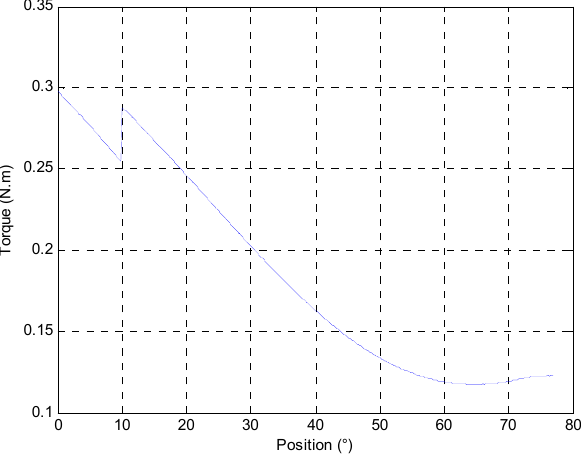
Figure 19. Load evolution according to the valve and flap position.